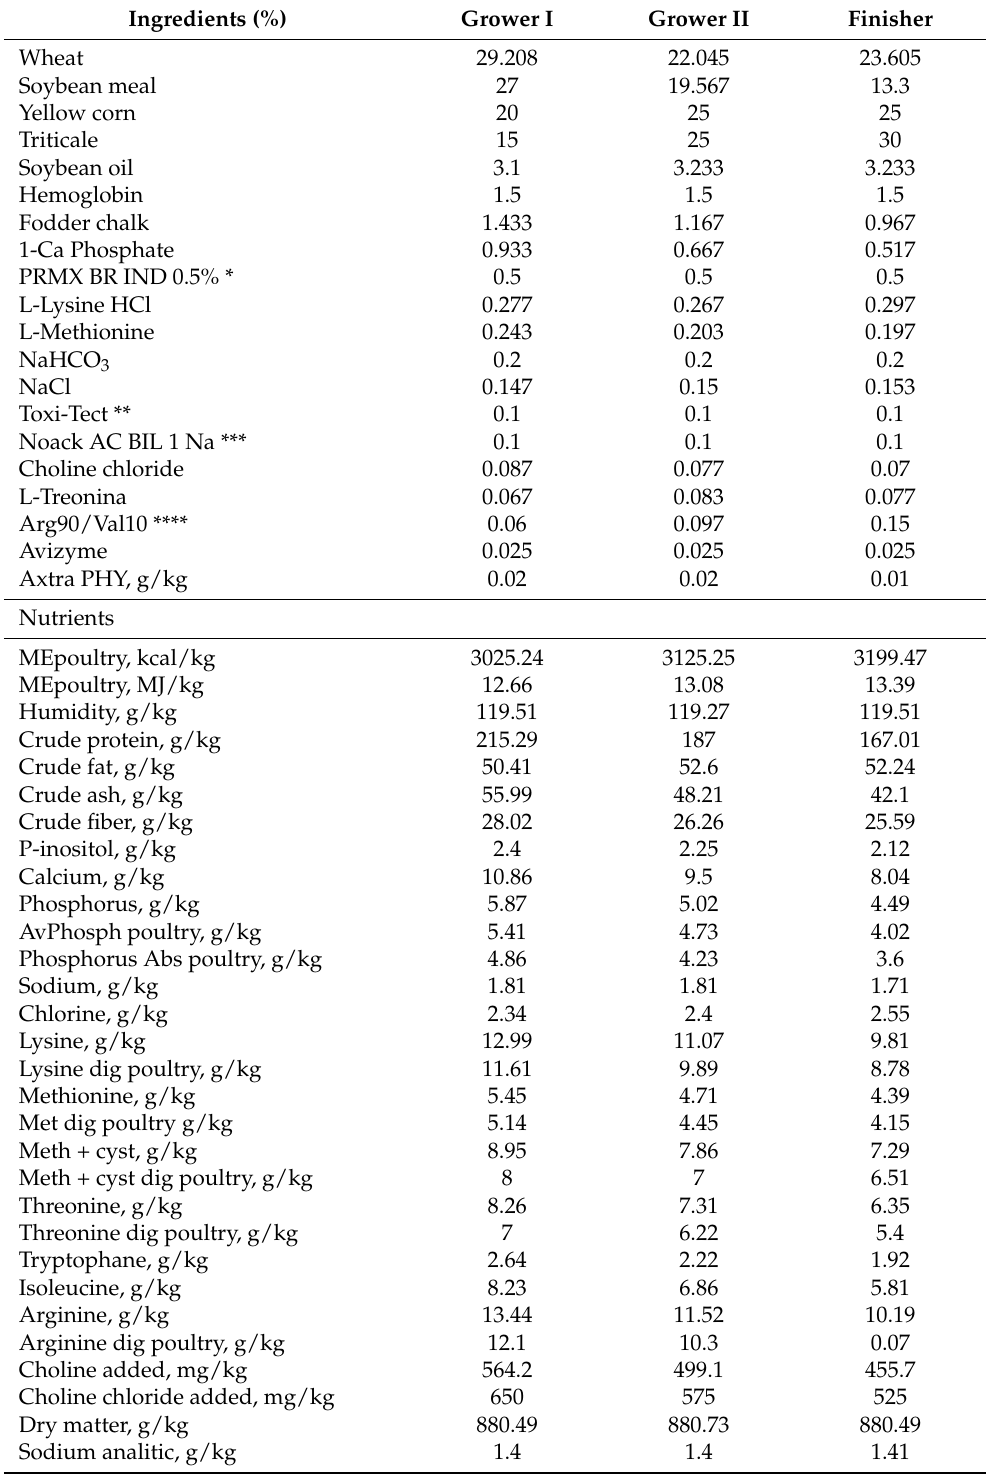
Table 1. Ingredients and composition of the standard diet and corn silage for turkey broilers according to the manufacturer’s specification (De Heus, Animal Feed Industry, Ł˛eczyca, Poland). Daily rations averaged 2 kg of grower I plus CS, 5 kg of grower II plus CS, and 5 kg of finisher plus